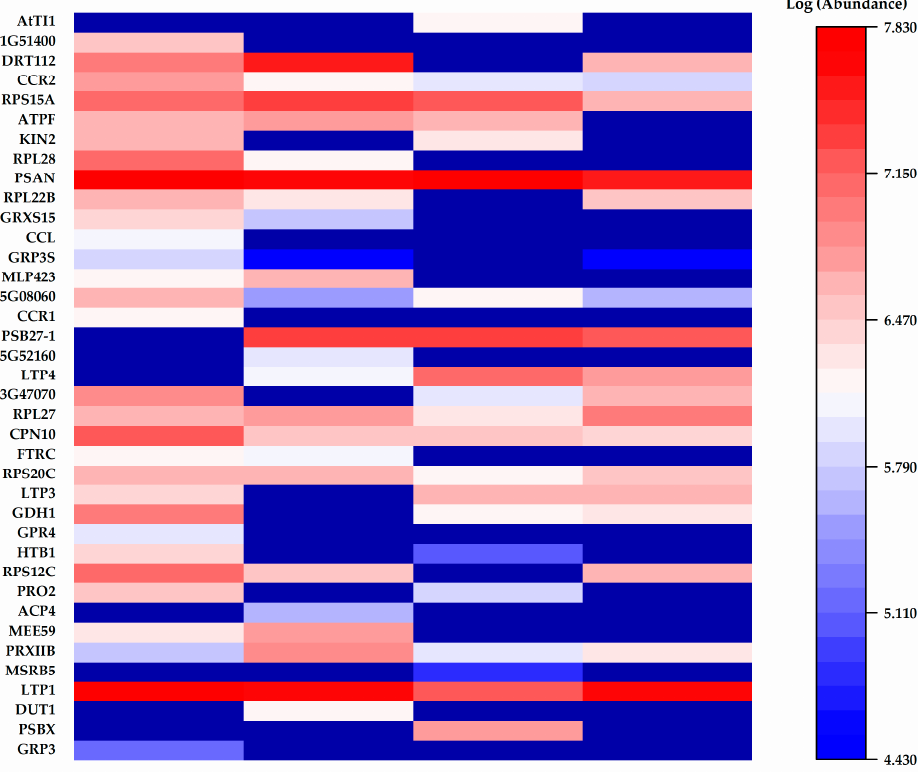
Figure 6. Abundance of potential SSPs in different Arabidopsis samples. WT-NAA represents wild type treated with NAA. yuc2yuc6 -NAA represents yuc2yuc6 treated with NAA.